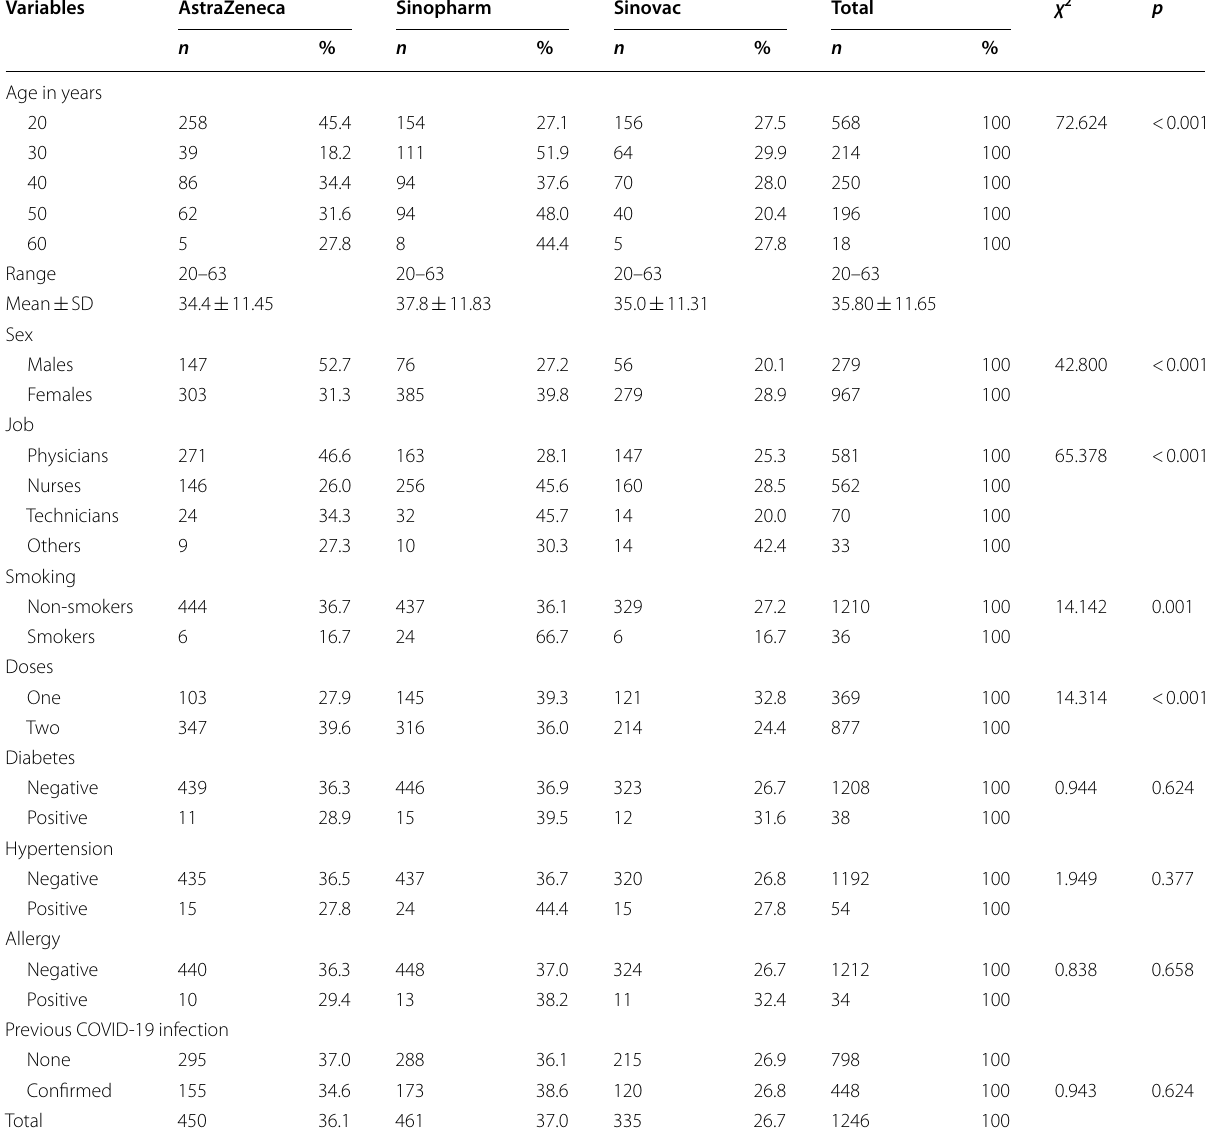
Table 1 Distribution of studied health care workers by type of vaccine Variables AstraZeneca Sinopharm